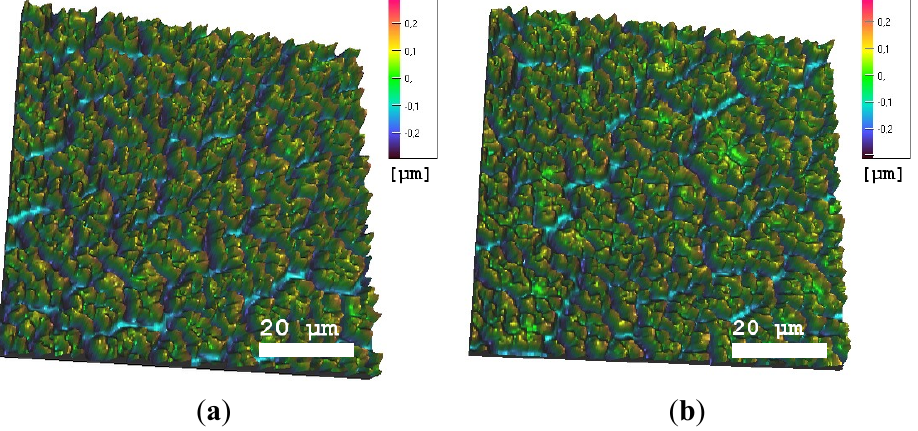
Figure 4. Confocal white-light microscopy of P(VDF-TrFE)-coated glass samples after thermal treatment at 140 °C, illustration of surface roughness; ( a ) with negative electric field applied during thermal treatment; and ( b ) positive electric field applied during thermal treatment of the same